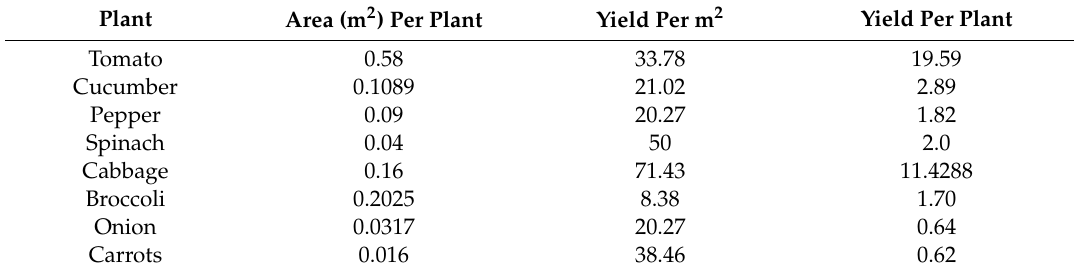
Table 2. Area needed per plant and yield per m 2 [71]. Table 3. Optimal plant quantities and